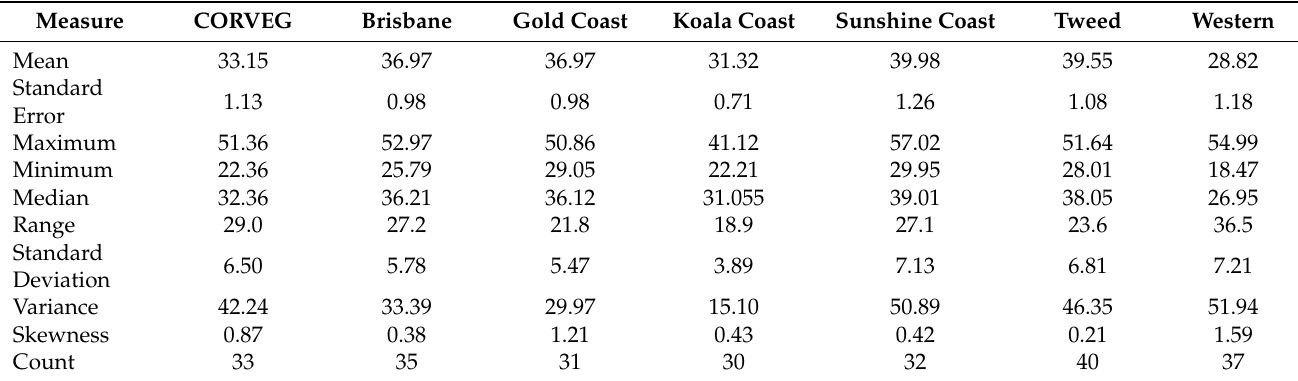
Table 6. Variations in the canopy height between CORVEG and six geographically distinct subregional groups within the study area (Figure 1).